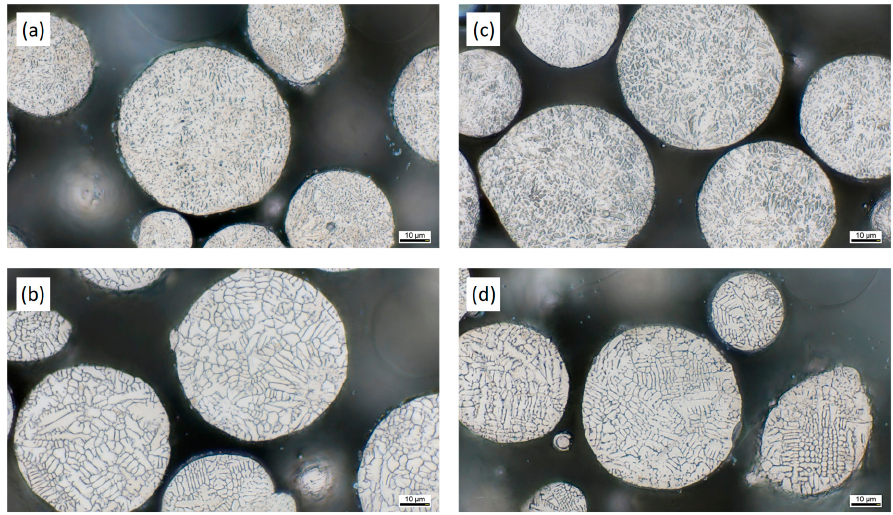
Figure 8. Optical micrographs of gas-atomized powder (particle size 20–63 µm): ( a ) 316L-Low Ni-1 Ar/Ar (Run 3), ( b ) 316L-Low Ni-1 N 2 /N 2 (Run 4), ( c ) 316L-Low Ni-2 Ar/Ar (Run 5), and ( d ) 316L-Low Ni-2 N 2 /N 2 (Run 6). The samples were etched with V2A etchant at 60 °C for 30 s.